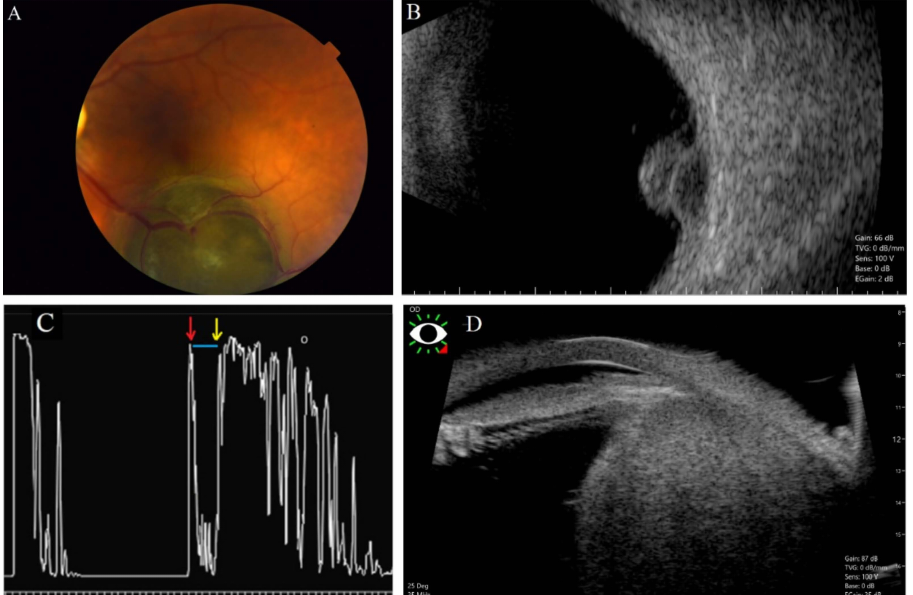
Figure 3. Echographic features of choroidal melanoma. Melanotic choroidal melanoma is mushroom- shaped as detected at the level of inferior arcade of the left eye ( A ). That was shown to be mushroom- shaped with acoustic hollowness in B-scan ( B ). One-dimensional A-scan imaging (8 MHz) for an eye with choroidal melanoma ( C ). The vertical deflections represent echoes from different surfaces in the eye. The red arrow indicates the surface of the retina, the yellow arrow indicates the surface of the sclera, and the interval between them (blue line) shows the low reflectivity of the tumor (choroidal melanoma). Ciliary body melanoma ( D ) detected in ultrasound biomicroscopy